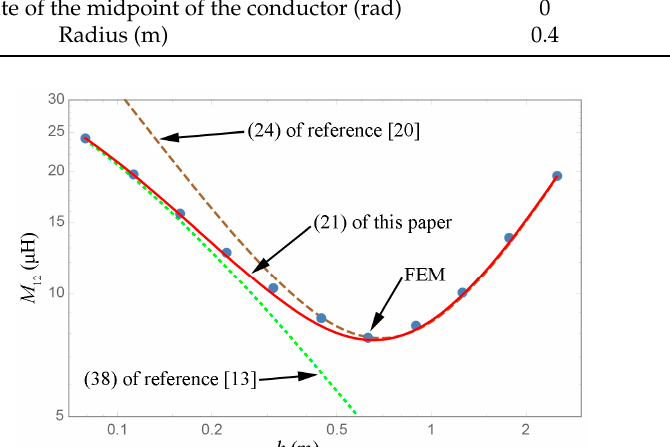
Figure 11. Mutual inductance ( M 12 ) of coils with different pitch lengths ( h ).